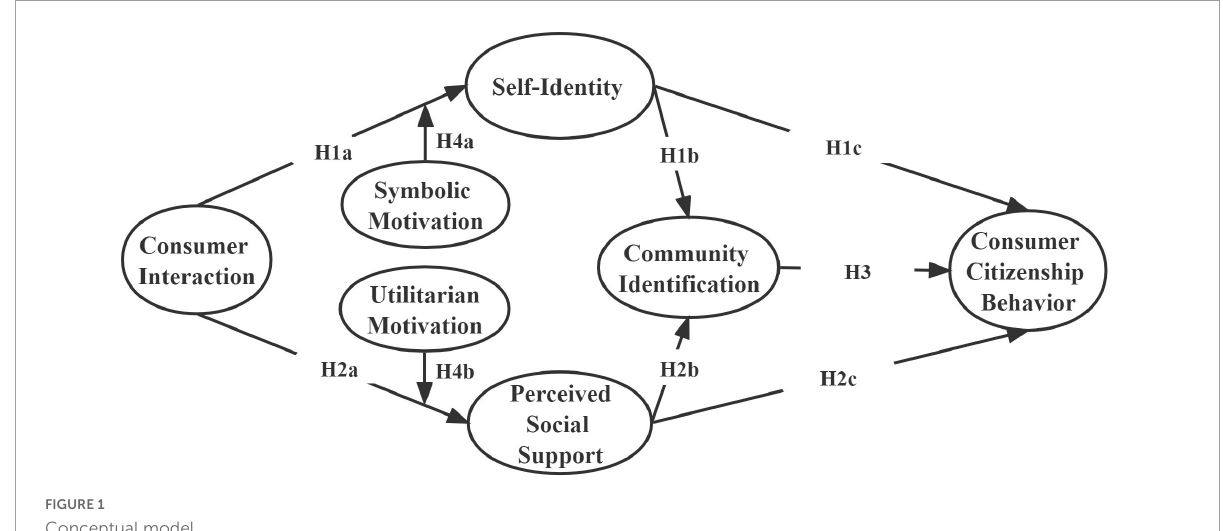
FIGURE1 Conceptual model.